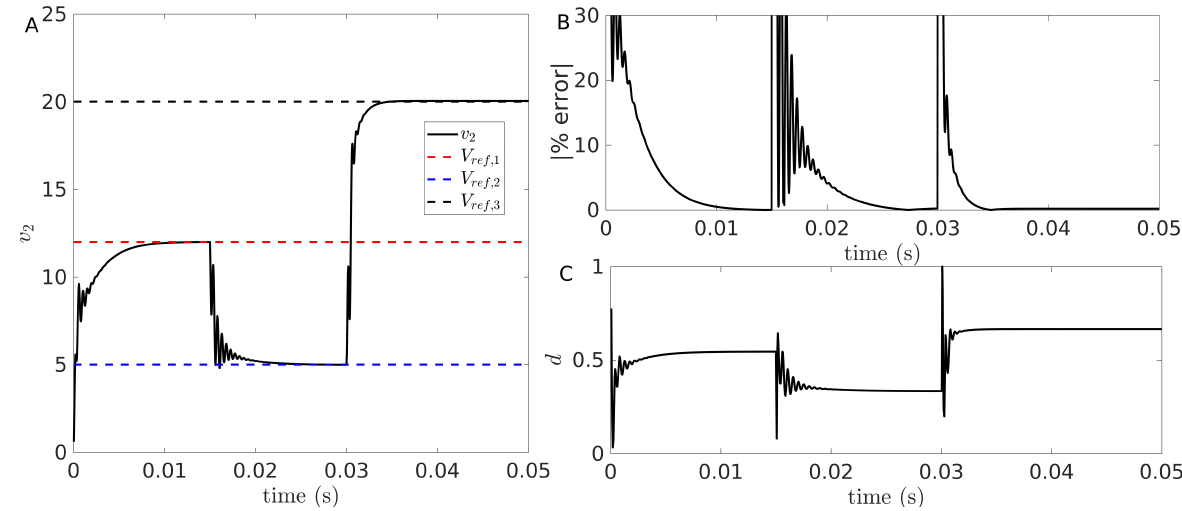
Figure 8. Time trace of the ramp controlled sZETA converter under perturbations of the reference voltage: ( A ) voltage trace; ( B ) error percentage; ( C ) duty cycle. In all panels, V ref ,1 = 12 V for t < 15 ms, V ref ,2 = 5 V for 15 ms ≤ t < 30 ms, and V ref ,3 = 20 V for t ≥ 30